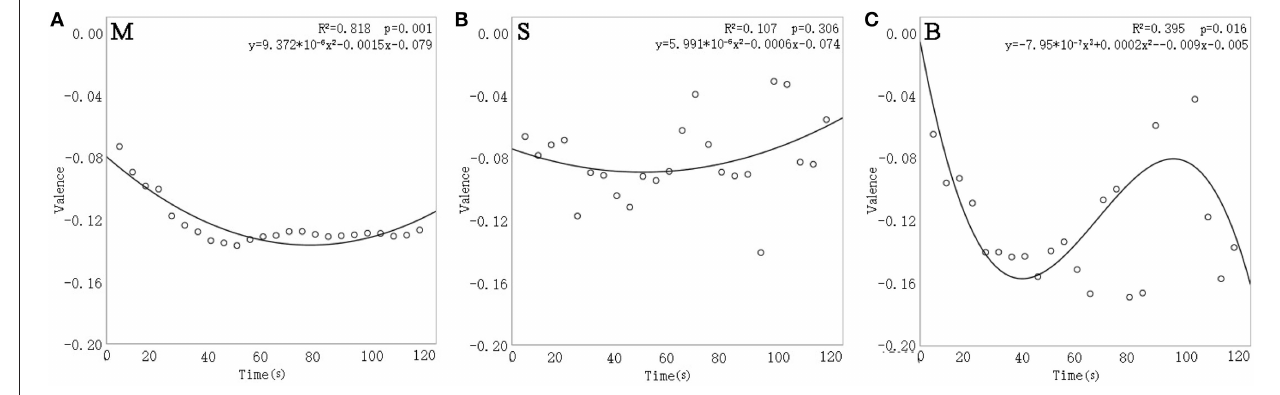
FIGURE 6 | The relationship between valence and time for the sound interventions of music (A) , stream (B) , and birdsong (C) .